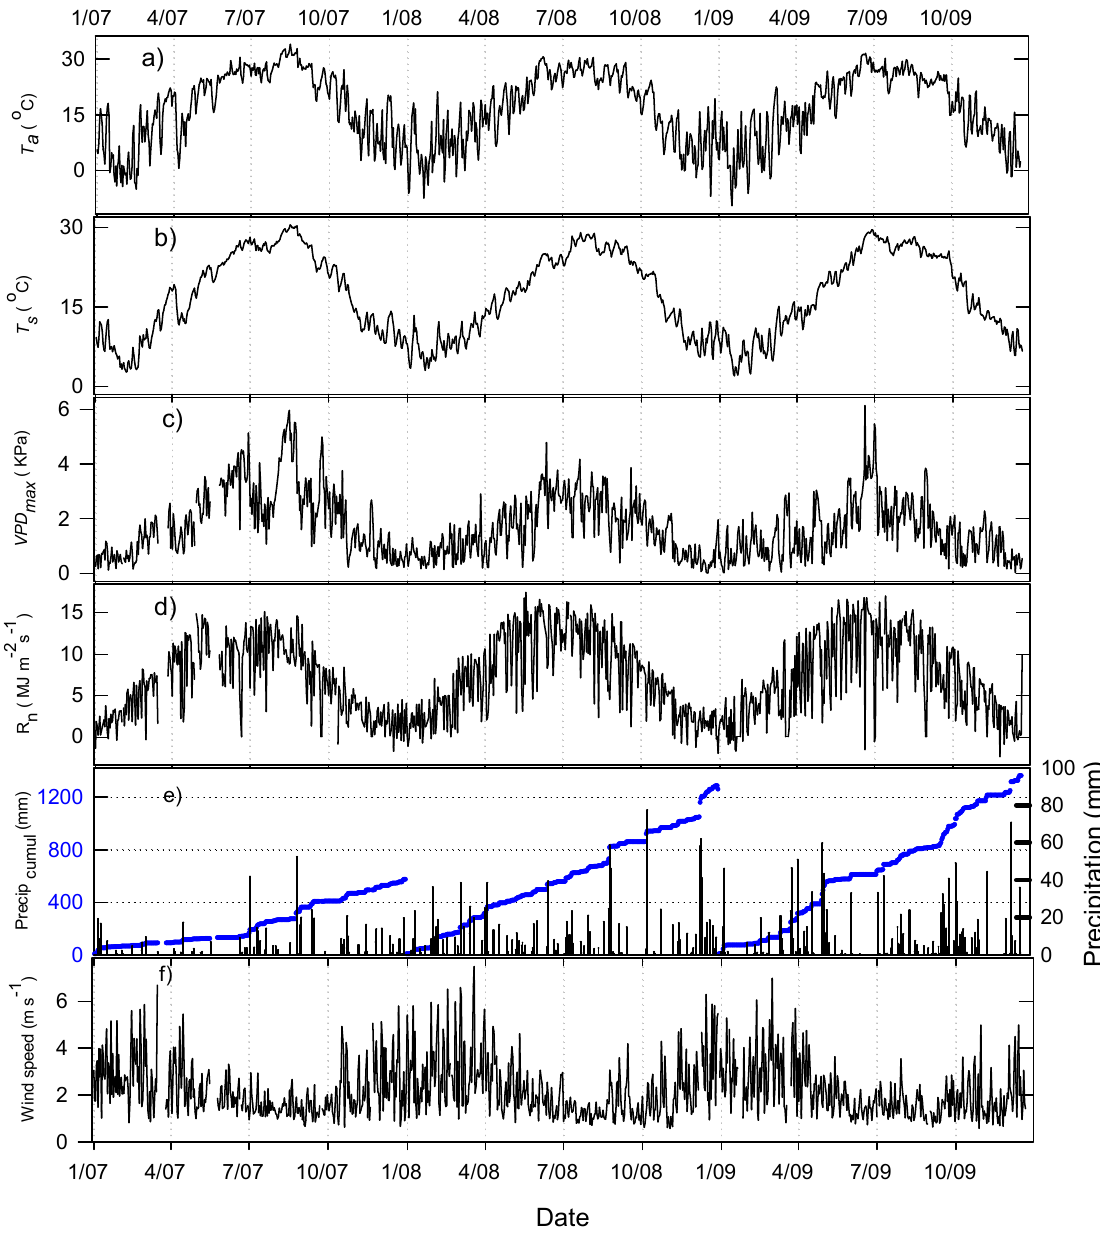
Figure 1. Time series of daily average ( a ) mean daily air temperature (sonic, T s ), ( b ) mean surface soil temperature ( c ) maximum daily vapor pressure deficit ( VPD ) ( d ) mean net radiation ( R n ) ( e ) daily and year cumulative precipitation (diagonal line) in (mm), and ( f ) mean daily horizontal wind speed (m s − 1 ) at WTARS for the study period